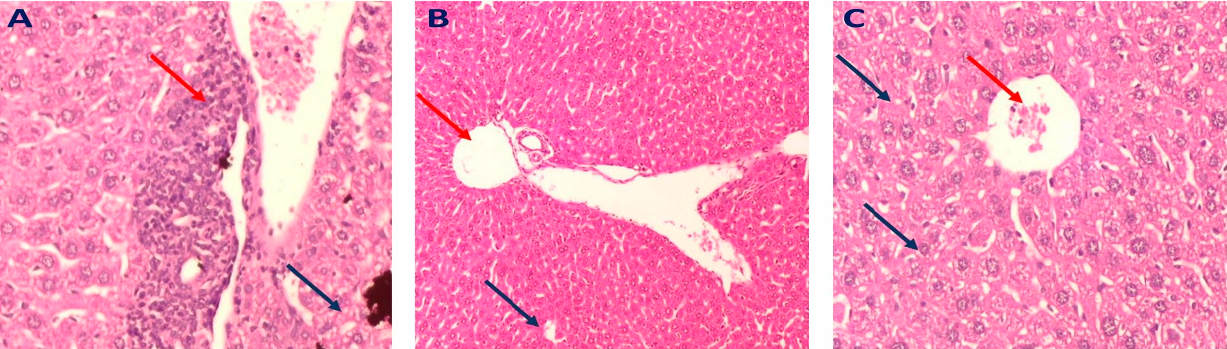
Figure 8. Representative photomicrograph of a liver section of mice groups that received different doses of total G. thunbergia methanol extract of leaves (H&E, ×200) as follows: ( A ); mice group received GME at 100 mg/kg: section of the liver displayed portal tract surrounded by marked inflammatory cellular infiltrate (red arrows) surrounded by hepatocytes with mild steatosis (blue arrow). ( B ); mice group received GME at 200 mg/kg: A section of the liver showed a portal tract (red arrow) surrounded by average-sized cords of hepatocytes (blue arrows) with no inflammation or steatosis. ( C ); mice group received GME at 300 mg/kg; showed dilated congested central vein tract (red arrow) with no inflammation and hepatocytes with mild steatosis.